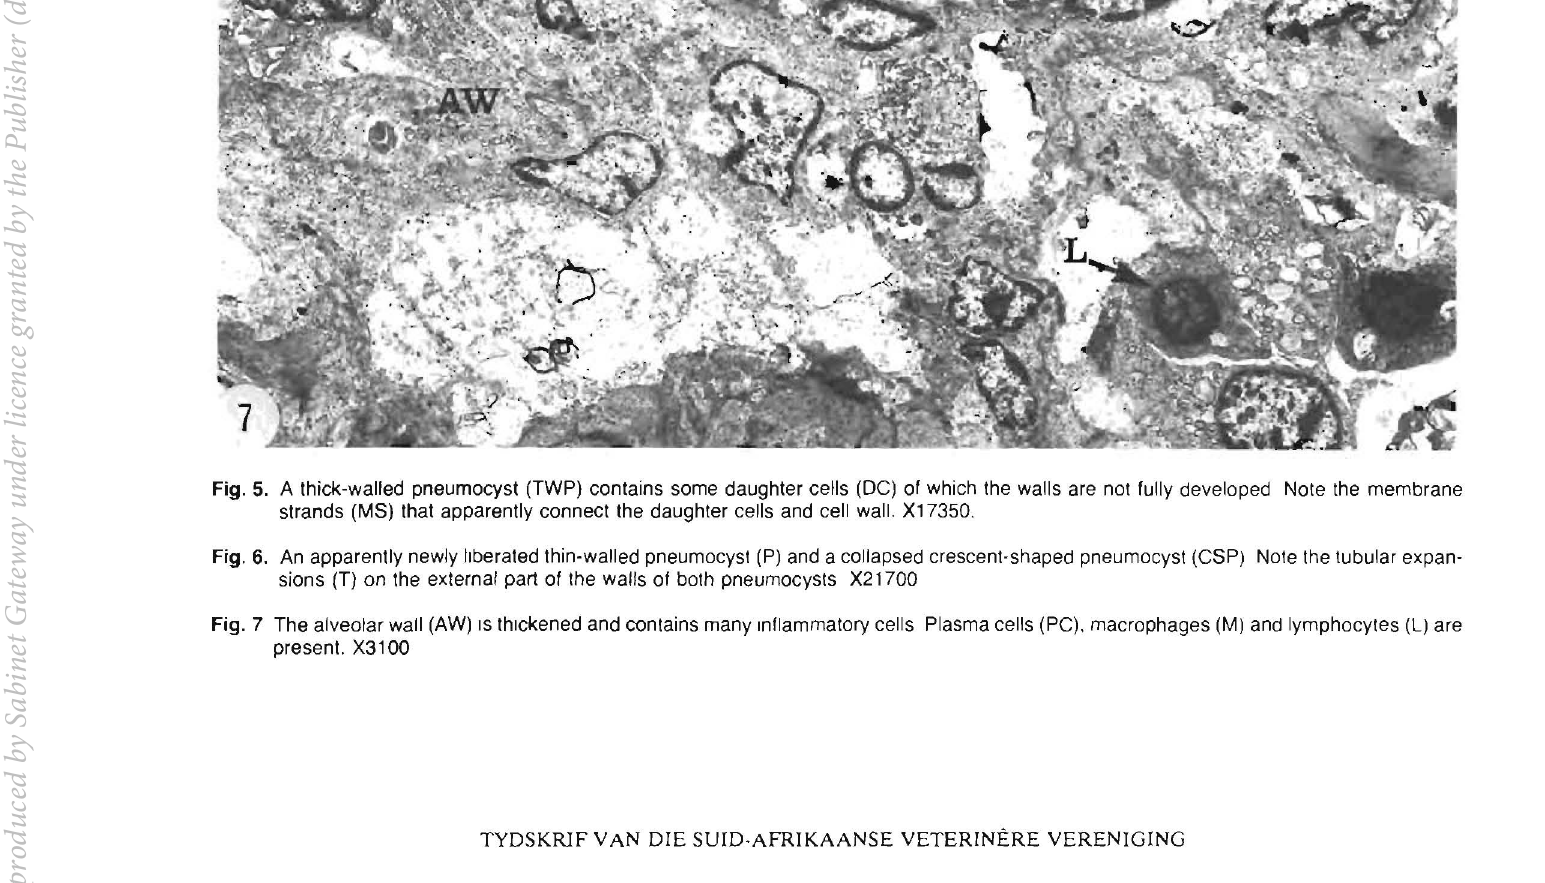
TYDSKRlF VAN DIE SUID·AFRIKAANSE VETERINERE